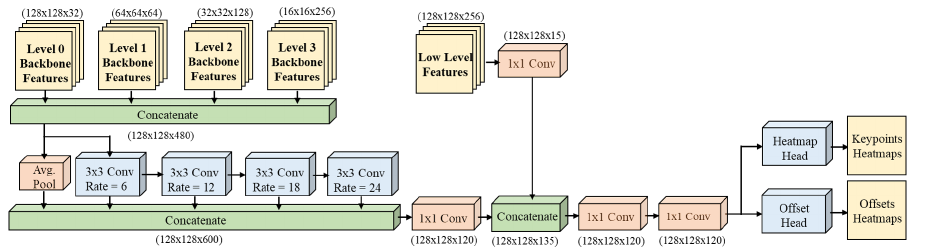
Figure 3. The D-WASP disentangled waterfall module. The feature sizes are denoted by the two spatial dimensions, followed by the channel dimension. The inputs are 32, 64, 128, and 256 feature maps from all four levels of the HRNet backbone, as illustrated in Figure 2, and low-level features from the initial layers of the framework. The module processes the backbone features at different rates of dilation in a waterfall fashion and outputs both the keypoints and offset heatmaps for each person